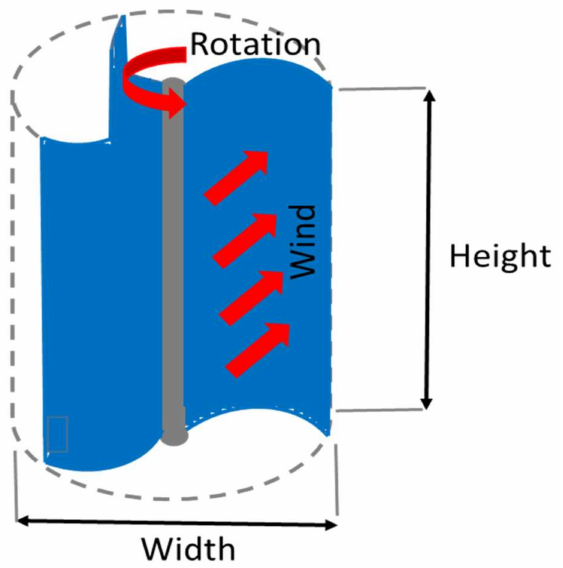
Figure 8. Savonius wind turbine.